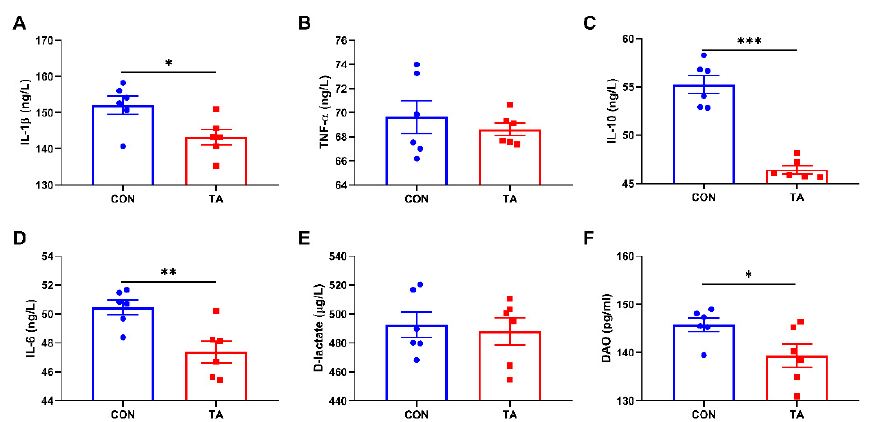
Figure 1. Effects of tannic acid extracted from Galla Chinensis supplementation on serum concentra- tions of inflammatory cytokines, D-Lactate, and diamine oxidase in broiler chickens. ( A ) Interleu- kin-1 beta (IL-1 β ); ( B ) Tumor necrosis factor-alpha (TNF- α ); ( C ) Interleukin-10 (IL-10); ( D ) Interleu- kin-6 (IL-6); ( E ) D-lactate; ( F ) Diamine oxidase (DAO). CON, broiler chickens fed basal diet; TA, broiler chickens fed basal diet supplemented with 300 mg/kg microencapsulated tannic acid ex- tracted from Galla Chinensis . Values are mean ± standard error ( n = 6). Differences between treat- ments were displayed by * p < 0.05, ** p < 0.01, and *** p < 0.001.